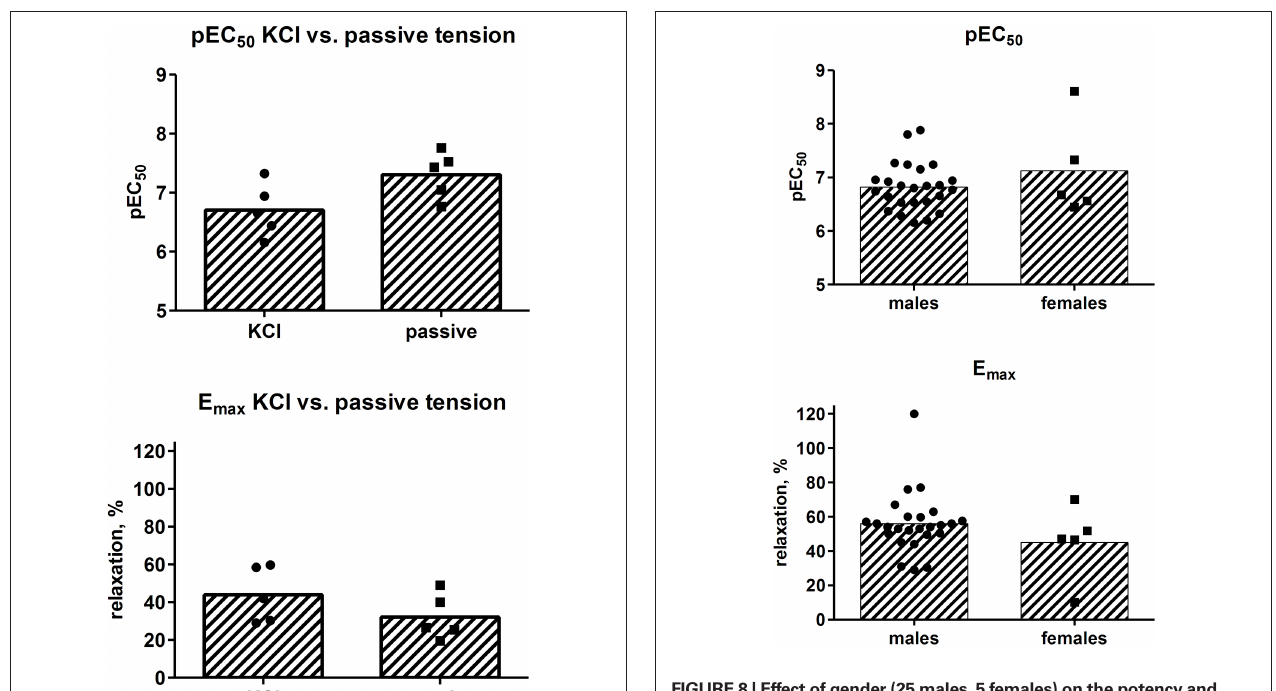
Figure 8 | effect of gender (25 males, 5 females) on the potency and efficacy of isoprenaline to relax human detrusor strips. Bars describe group means whereas each data point represents one patient (1–4 strips being tested per patient).